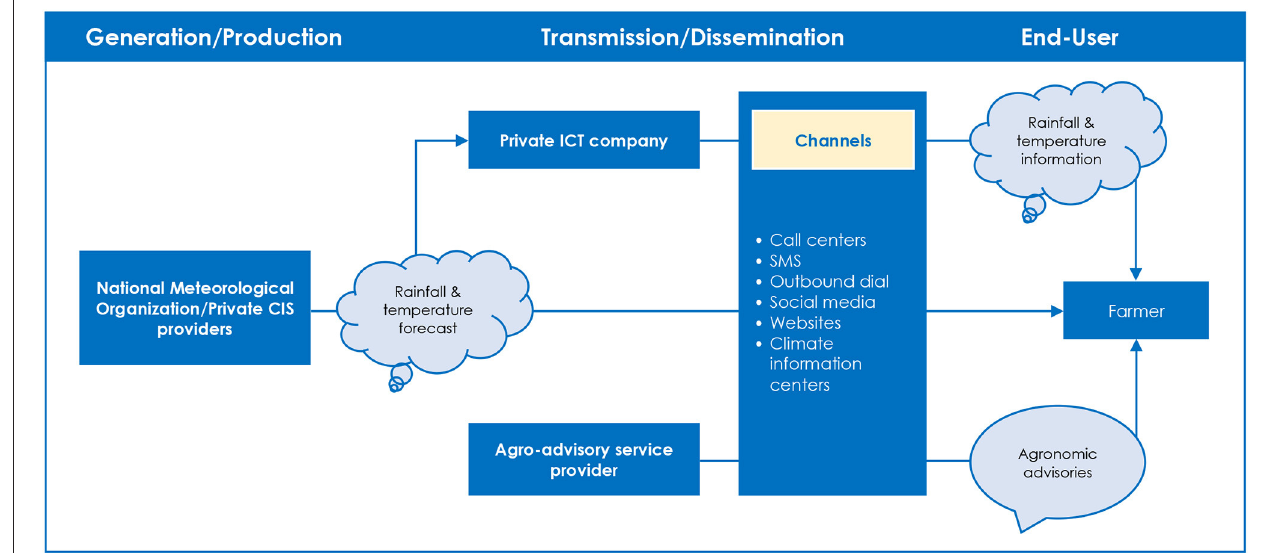
FIGURE 1 | Existing linear model of CIS production in Ghana produced by